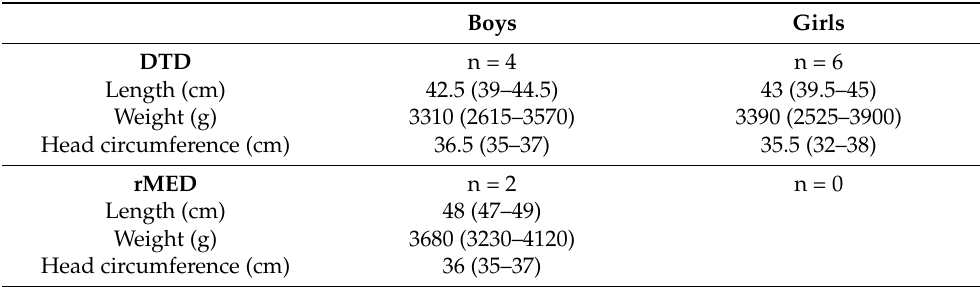
Table 2. Growth data at birth for children affected with DTD and rMED. Data presented as median